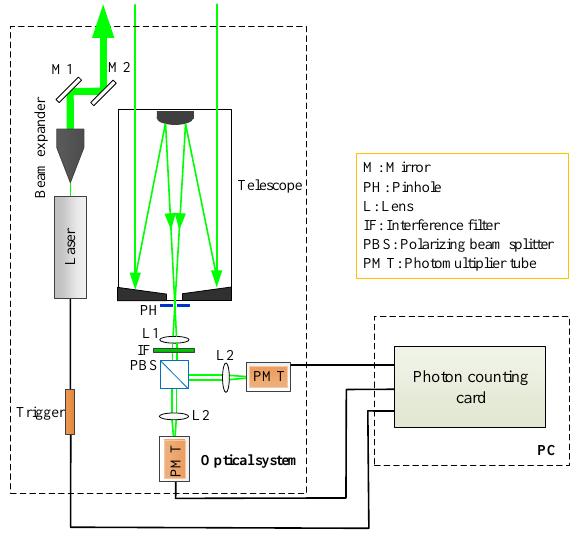
Figure 2. The schematic diagram of the P-MPL (polarized micropulse lidar). The specifications of the P-MPL are shown in Table 1.